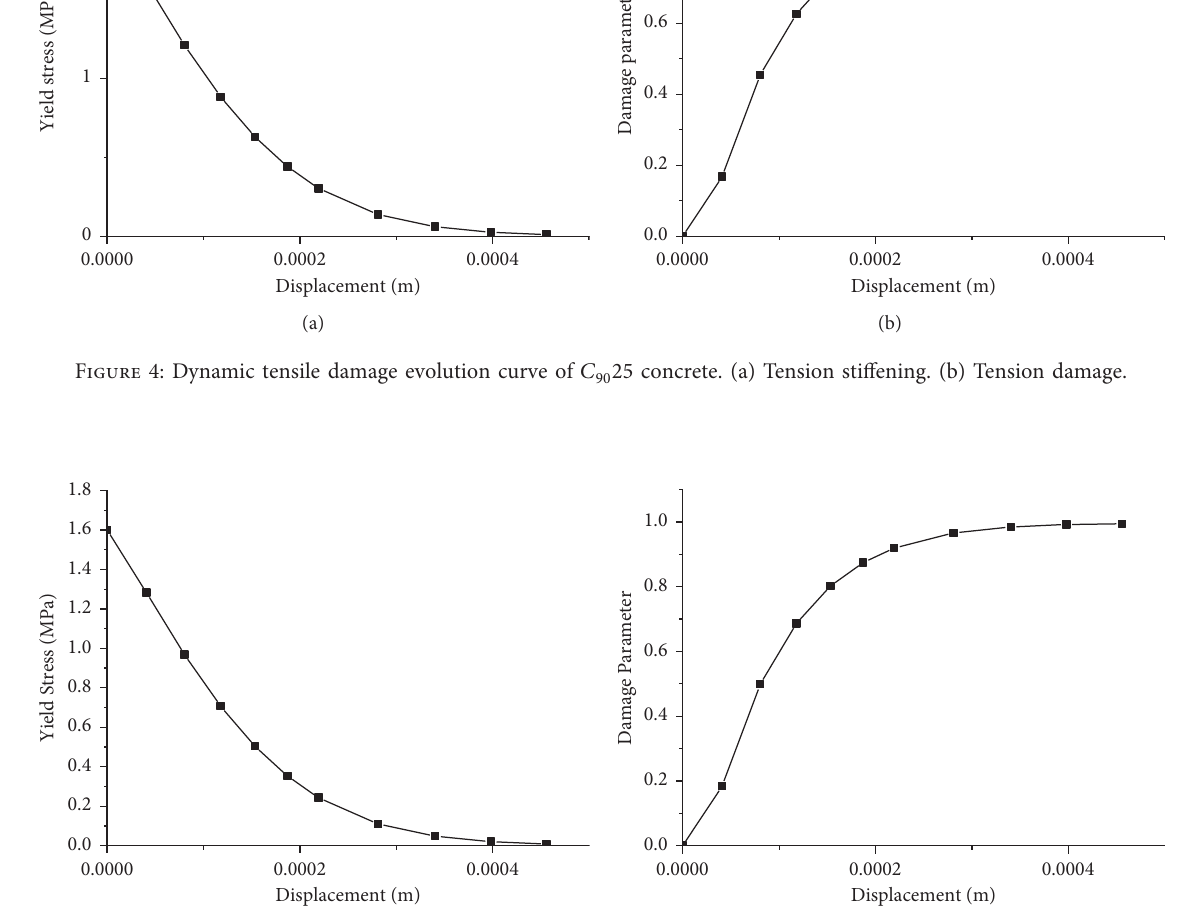
20 concrete. (a) Tension stiffening. (b) Tension 90